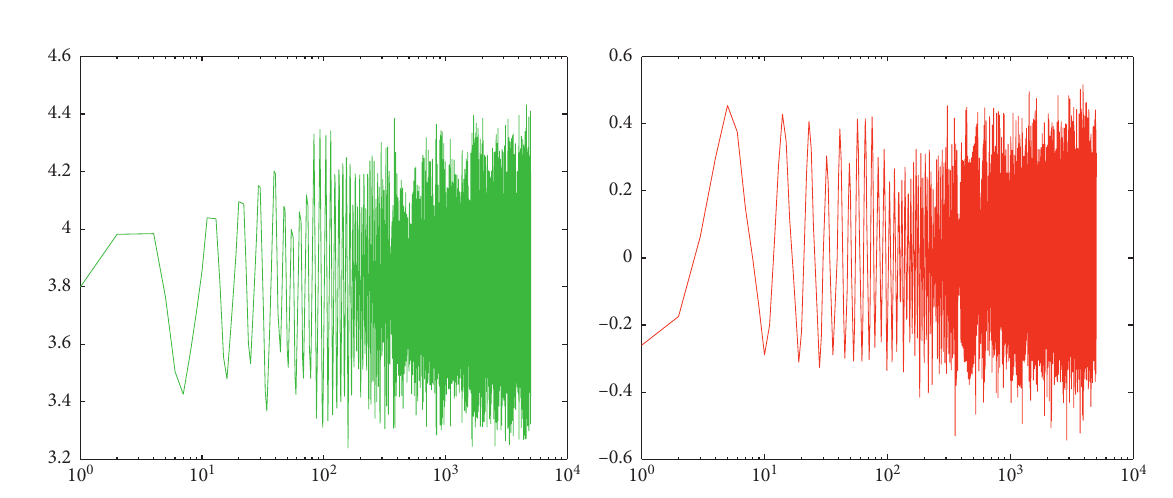
Figure 4: Evaluated data.